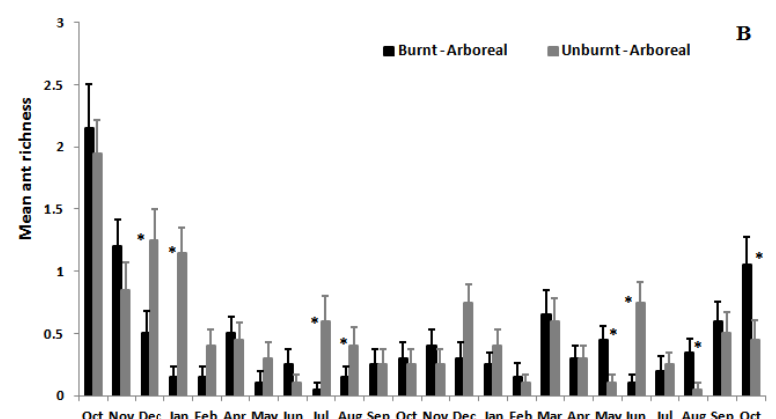
Figure 3. Variation in mean richness of ground ant species ( A ) and arboreal ant species ( B ) at Itacolomi State Park over two years in burnt (black bars) vs. unburnt (grey bars) areas. Asterisks indicate significant differences among months ( p < 0.05). Insects 2017 , 8 , 64